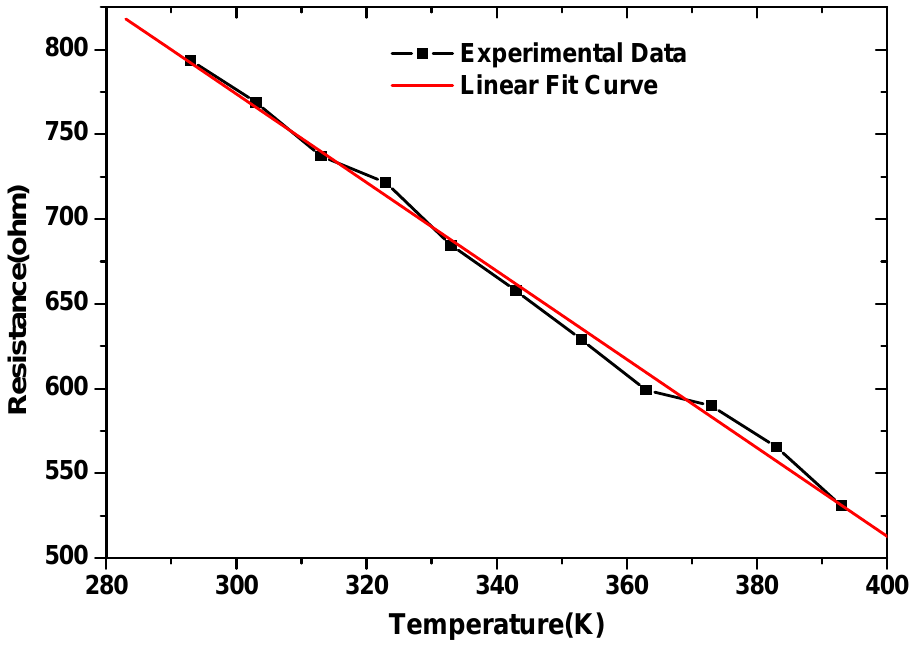
Figure 6. Temperature dependence of the resistance of the MWCNT